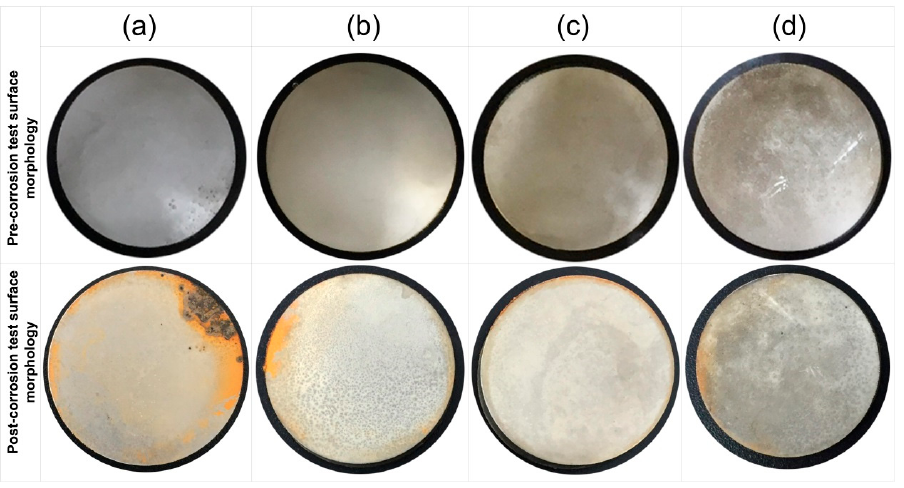
Figure 1. Corrosion status of electrodeposited composite coatings immersed in 5% NaCl solution